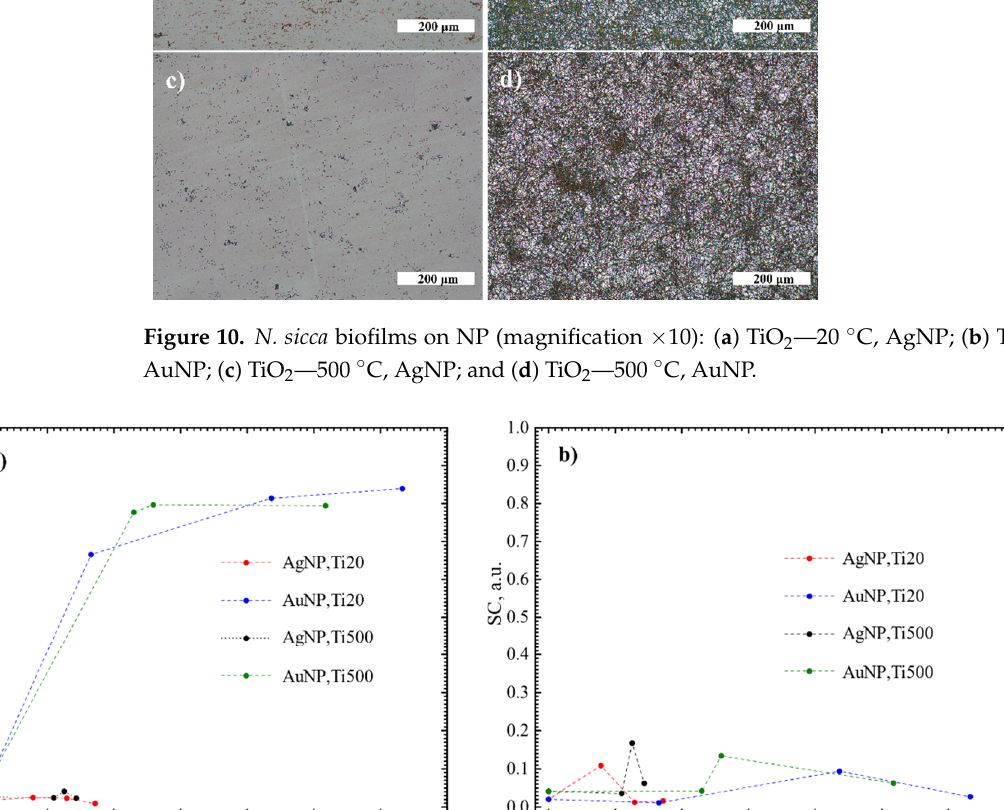
Figure 10. N. sicca biofilms on NP (magnification ×10): ( a ) TiO 2 —20 °C, AgNP; ( b ) TiO 2 —20 °C, AuNP; ( c ) TiO 2 —500 °C, AgNP; and ( d ) TiO 2 —500 °C, AuNP.